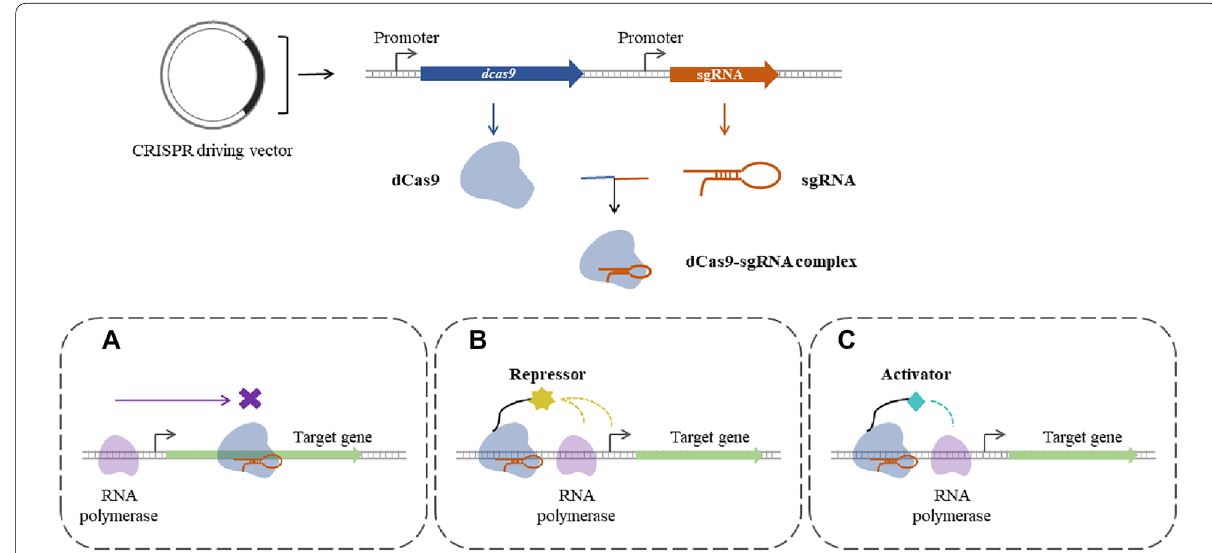
Fig. 2 Transcription regulation mechanism of CRISPR-based strategies. A Regulation mechanism of CRISPRi: inhibit transcription process by blocking RNA polymerase; B Regulation mechanism of CRISPRi: repress the transcription of target genes by handling a repressor; C Regulation mechanism of CRISPRa: activate the transcription of target genes by handling an